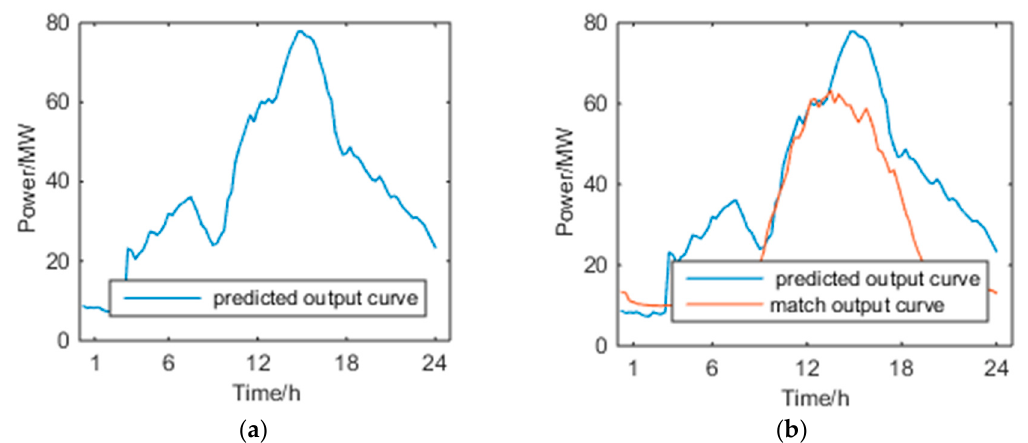
Figure 15. Output curves: ( a ) The predicted output curve of someday; ( b ) The predicted output curve of someday and most similar typical scenario output curve. Table 9. Virtual power plant initial return and optimal